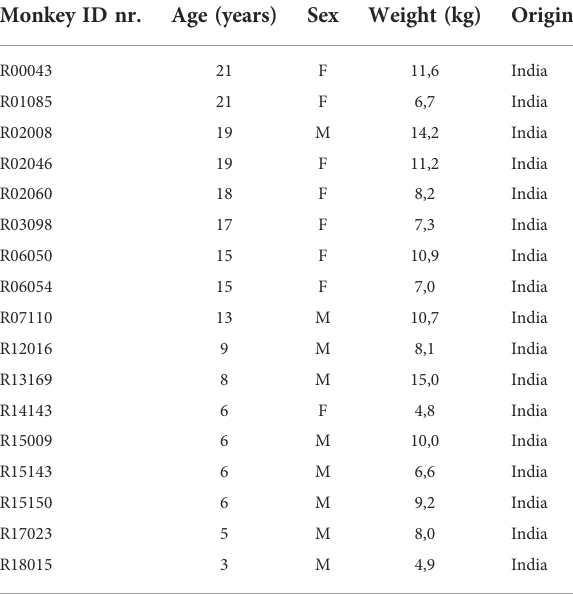
TABLE 1 Individual identi fi cation data of rhesus macaques. Monkey ID